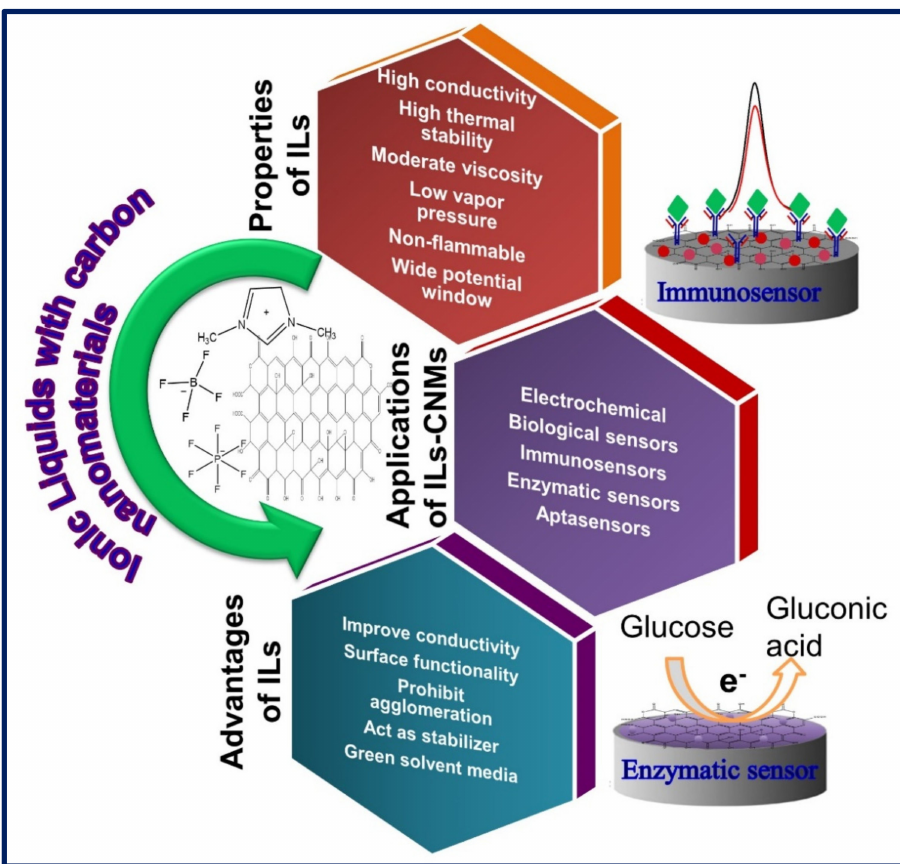
Figure 2. Representation of the properties, applications, and advantages of